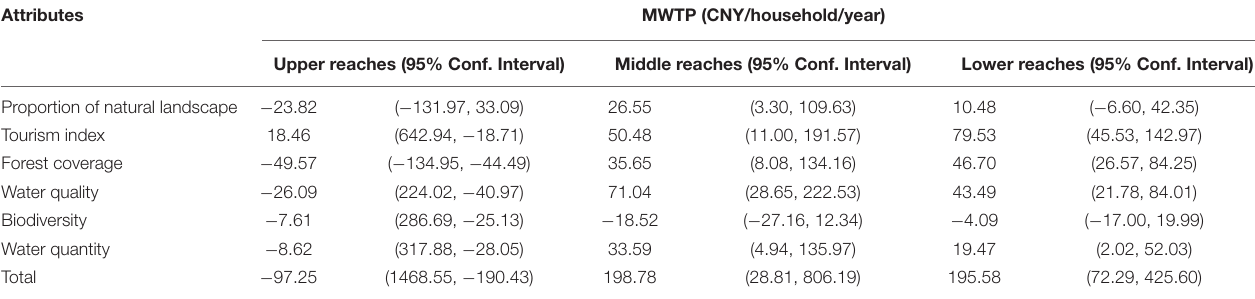
TABLE 6 | Estimation of marginal WTP/WTA on RPL model. Attributes MWTP (CNY/household/year) Upper reaches (95% Conf. Interval) Middle reaches (95% Conf. Interval) Lower reaches (95% Conf. Interval) Proportion of natural landscape −